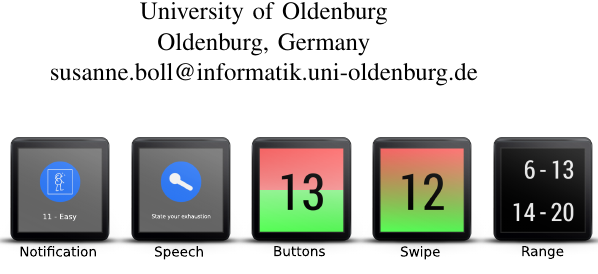
Fig. 1. Input methods created for this